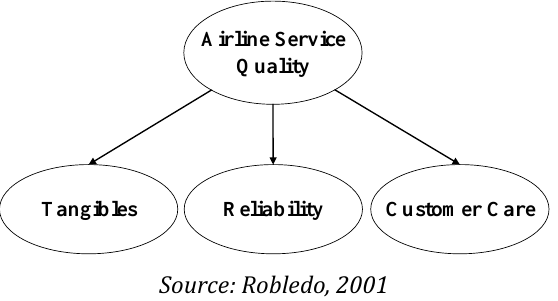
Figure 9: Dimensions of airline service quality in